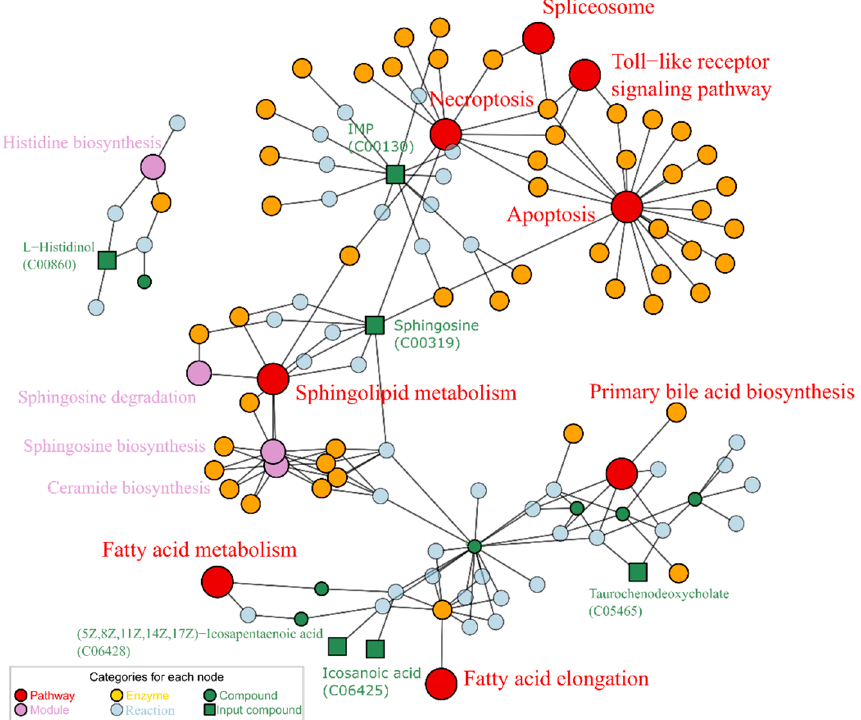
Figure 6. Enriched map based on repaired metabolites by puerarin, enrichment p score < 0.01.